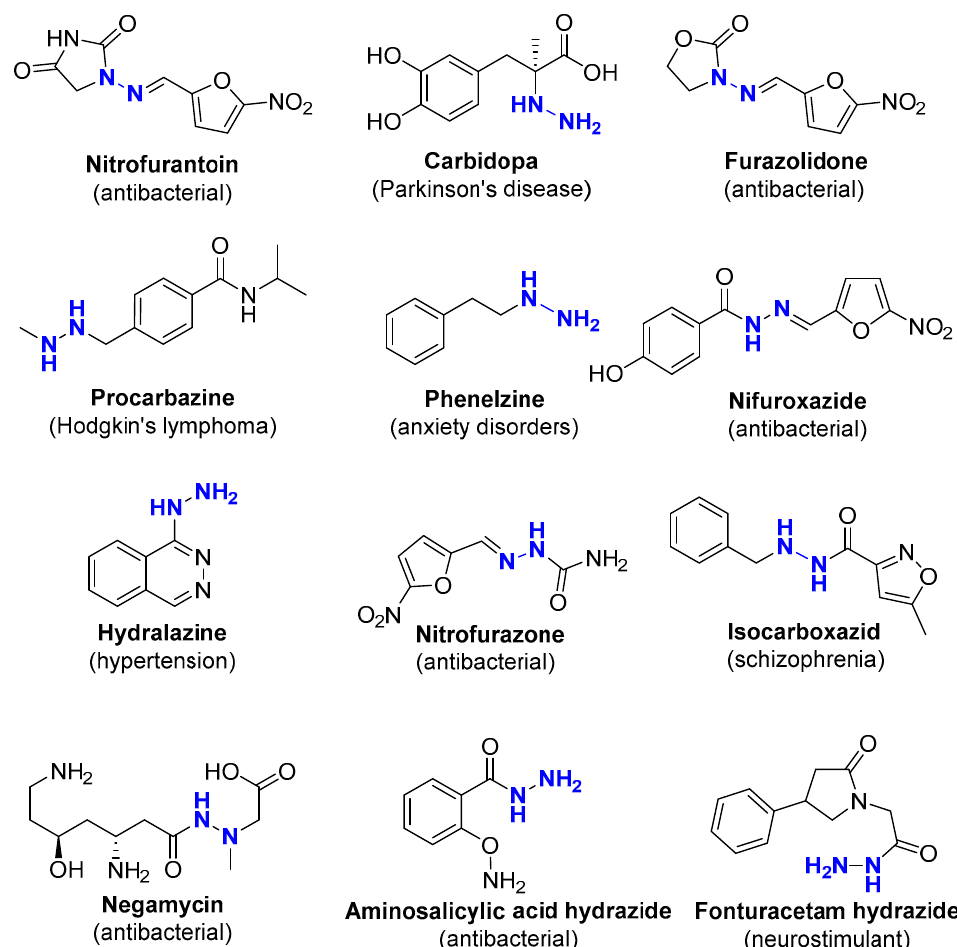
Figure 3. Hydrazide-based drugs in clinical use.